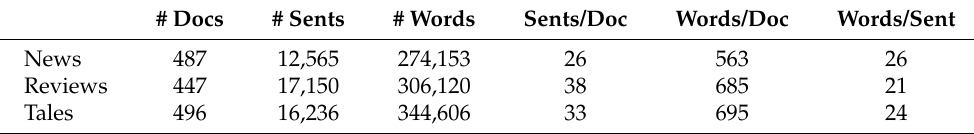
Table 1. Description of the